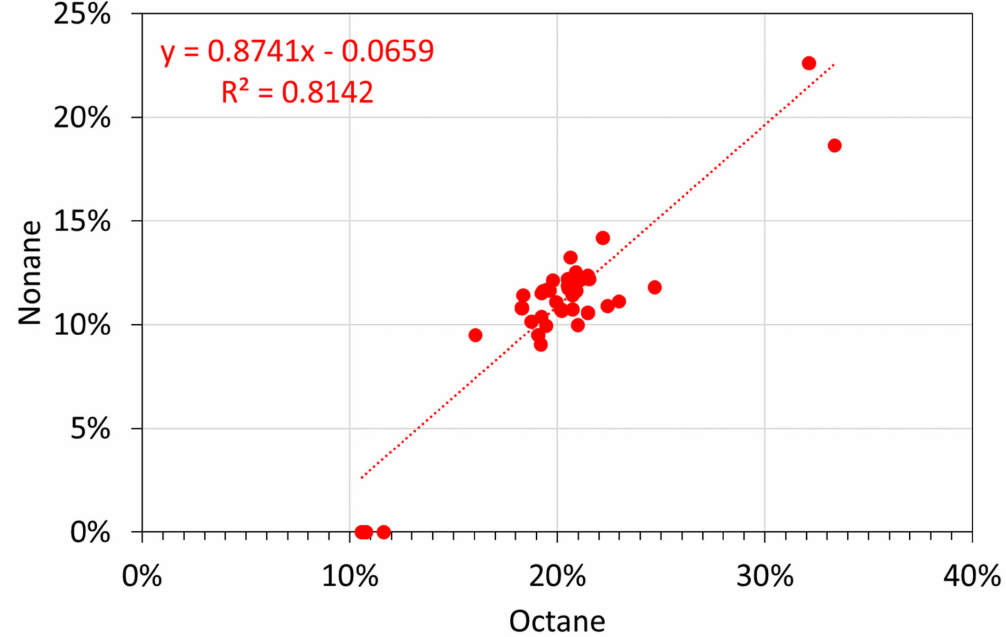
Figure A18. Molar alkane oil analyses: octane vs.